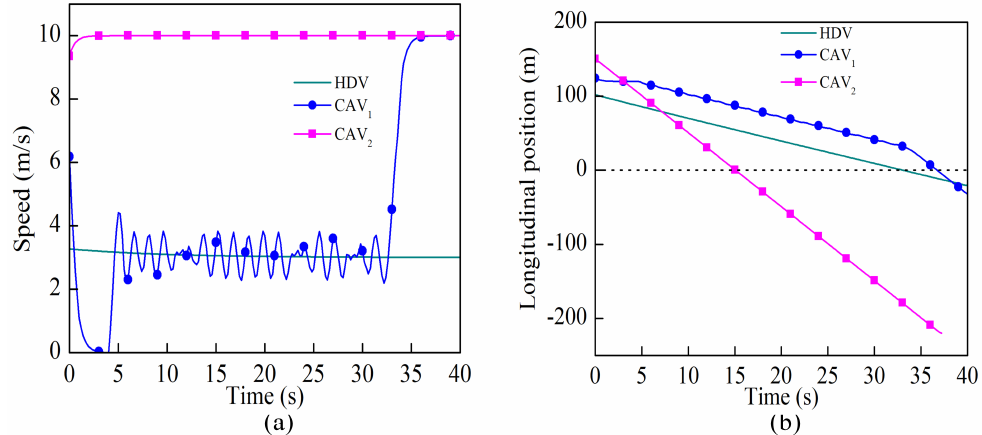
Figure 12. The speed and position curves of all the vehicles when the HDV traveled at a low speed using the proposed algorithm; ( a ) the speed, ( b ) the position.